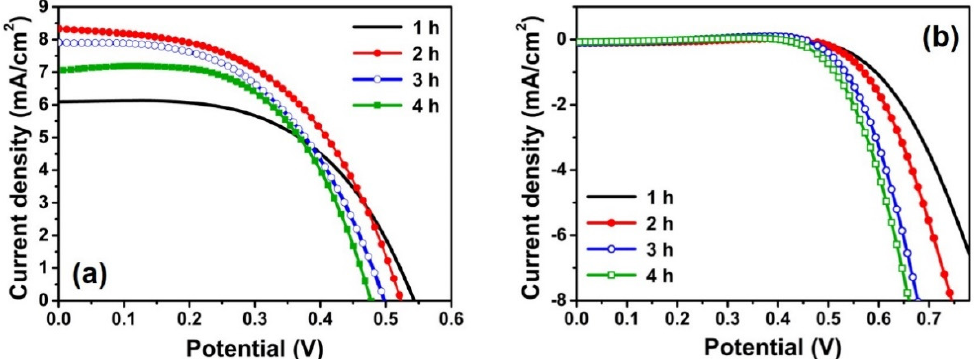
Figure 4. ( a ) Photocurrent density–voltage ( J-V ) characteristic curves in ( a ) illuminated (light intensity: 100 mW / cm 2 ; AM 1.5 G conditions); and ( b ) dark states of the quasi-solid-state DSSCs based on the anodic TiO 2 NT electrodes depending on the anodization